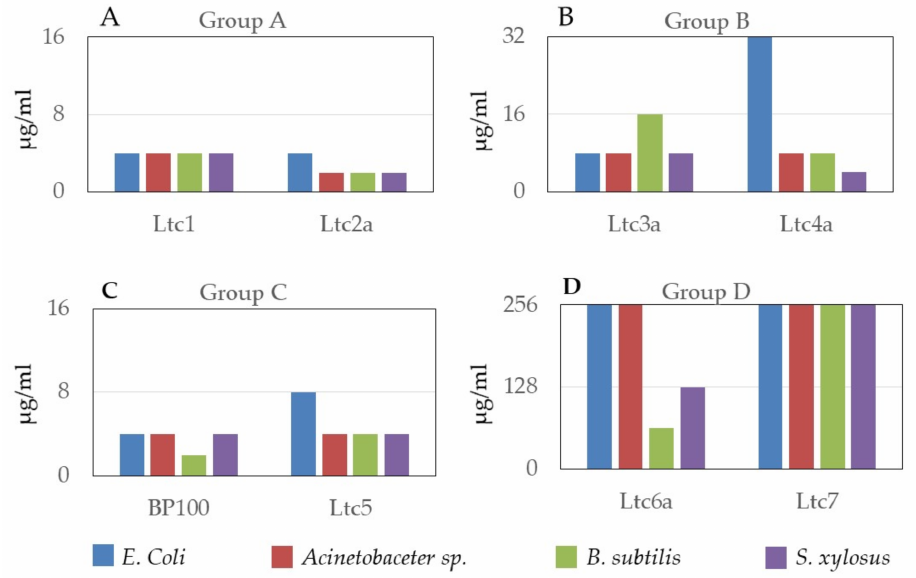
Figure 3. Minimal inhibitory concentration (MIC) values of all latarcins determined for two Gram- positive ( Bacillus subtilis subsp. spizizenii and Staphylococcus xylosus) and two Gram-negative strains ( Escherichia coli and Acinetobacter sp.). ( A ) Group A peptides (Ltc1 and Ltc2a); ( B ) Group B peptides (Ltc3a and Ltc4a); ( C ) Group C peptide (Ltc5) and positive control (BP100); ( D ) Group D peptides (Ltc6a and Ltc7).